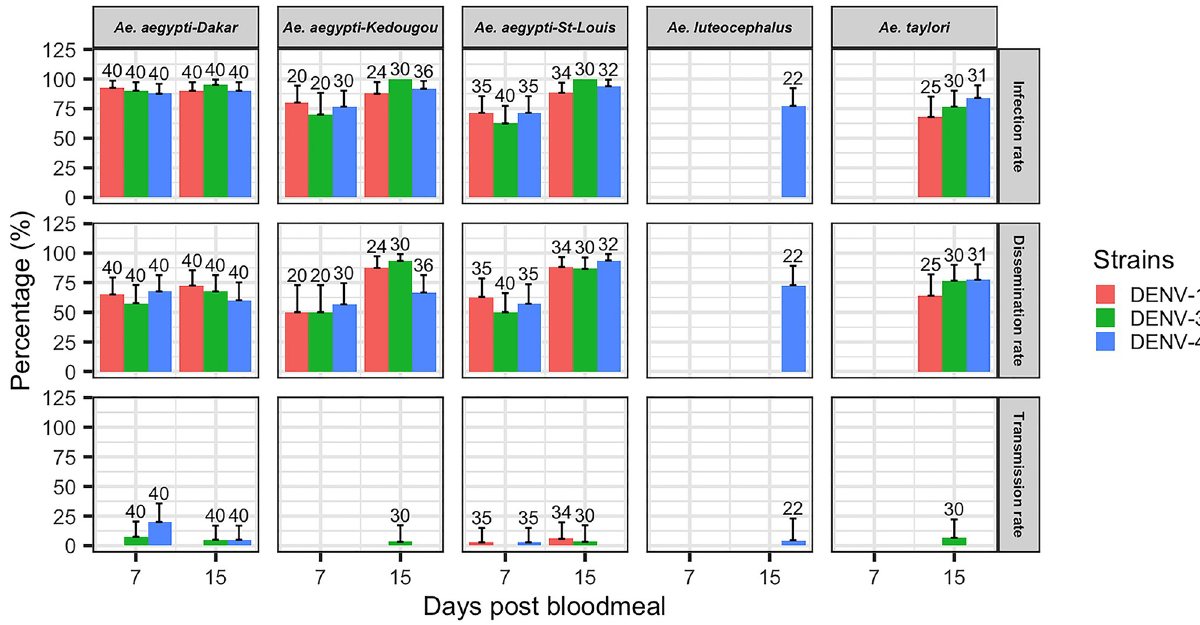
Fig 2. Infection, disseminated infection and transmission rates of four Senegalese Aedes mosquitoes orally exposed to different dengue serotypes at 7 and 15 days post bloodmeal. Error bars represent the upper limits of the 95% confidence intervals of infection, dissemination and transmission